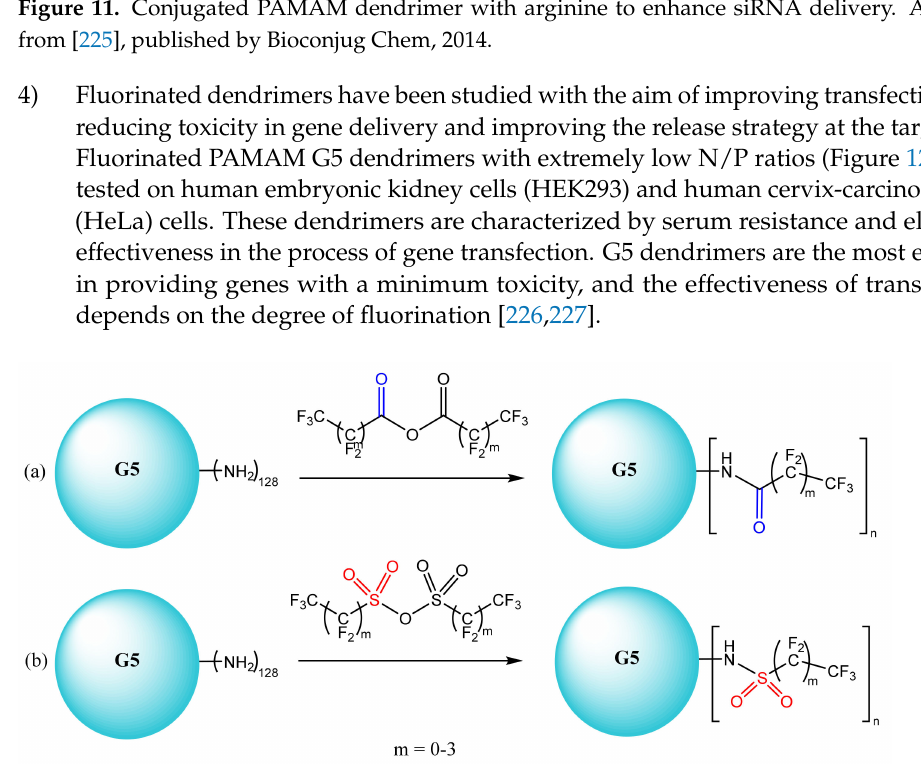
Figure 12. Obtaining fluorinated PAMAM dendrimers ( a )-reaction of G5-PAMAM dendrimers with perfluoro anhydrides of carboxylic acids, ( b )-reaction of G5-PAMAM dendrimers with perfluoro anhydrides of sulphonic acids. Adapted from [227], published by Nat Commun,